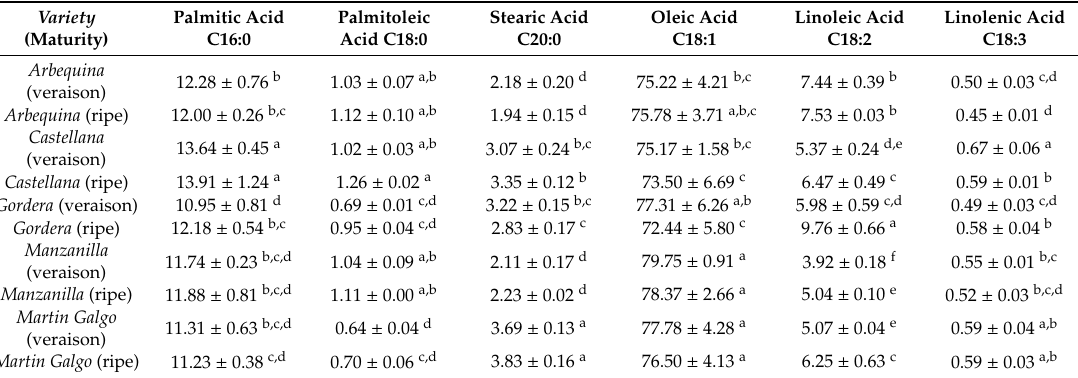
Table 3. Main fatty acids present in the samples of virgin olive oil analyzed, from the di ff erent olive varieties grown in the study area, collected at di ff erent stages of